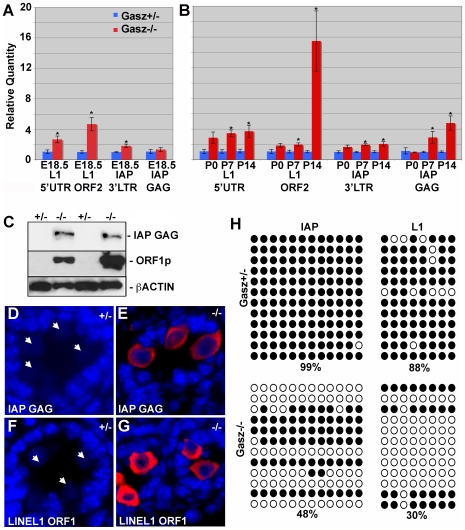
Dysregulation of transposable elements in Gasz null testes.(A–B) Quantitative RT-PCR analysis of transposable elements in testes from embryonic, newborn, 7- and 14-day-old mice (mean±SEM). (C) Western blot analysis of testis samples from 14-day-old mice by using anti-GAG (Upper), anti-ORF1 (Middle), or anti-β-actin control (Lower) demonstrated increased IAP GAG and LINE L1 ORF1p expression in Gasz−/− testes. (D–G) Immunofluorescent analysis of IAP GAG (D–E) and ORF1p (F–G). Robust staining of IAP GAG and ORF1p is detected in Gasz−/− gonocytes (E,G) but absent from Gasz+/− controls (D,F). (H) CpG methylation analysis of IAP and LINE L1 using bisulfite-converted testicular genomic DNA. Methylated CpG dinucleotides remain unconverted as cytosine (filled circles) and unmethylated cytosines are converted to uracils and amplified as thymidines (open circles). Percentages of CG dinucleotide methylation are given.